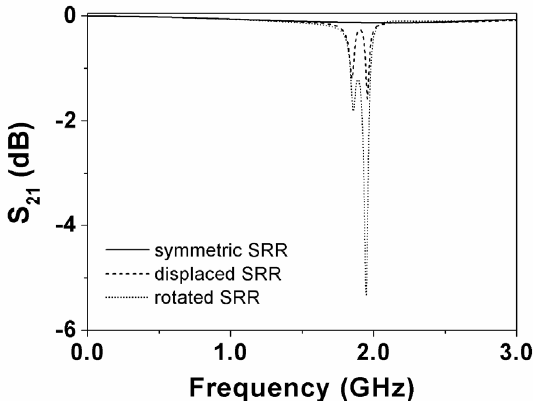
Figure 3. Simulated transmission coefficients of the structures of Figure